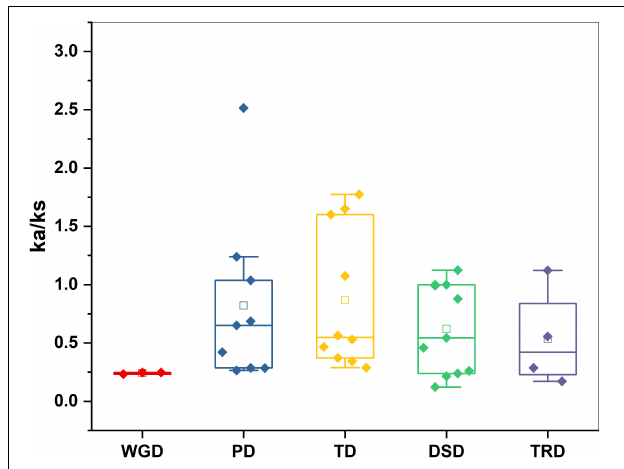
FIGURE 5 | Ka/Ks values of GST genes family in Prunus avium . Comparison of Ka/Ks values for different modes of gene duplications. WGD, whole-genome duplicates; PD, proximal duplicates; TRD, transposed duplicates; TD, tandem duplicates; DSD, dispersed